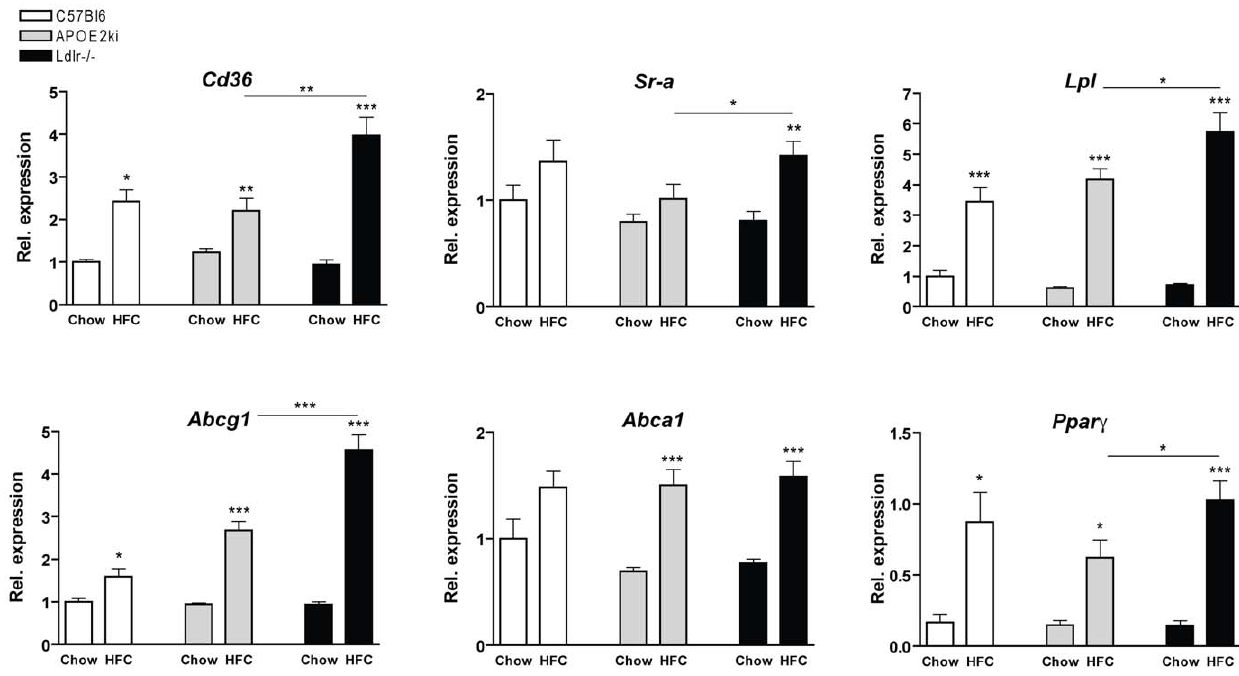
Figure 5. Cholesterol-related hepatic gene expression. Gene expression analysis of Cd36 , scavenger receptor A (Sr-a) , lipoprotein lipase (Lpl) , ATP binding cassette G1 (Abcg1) and A1 (Abca1) and peroxisome proliferator activated receptor (Ppar- c ) after chow and 3 months of HFC diet in C57Bl6, APOE2ki and Ldlr 2 / 2 mice. Data were set relative to the C57Bl6 mice on the chow diet. * Significantly different from chow group. *, ** and *** indicate p , 0.05, 0.01 and 0.001, respectively.